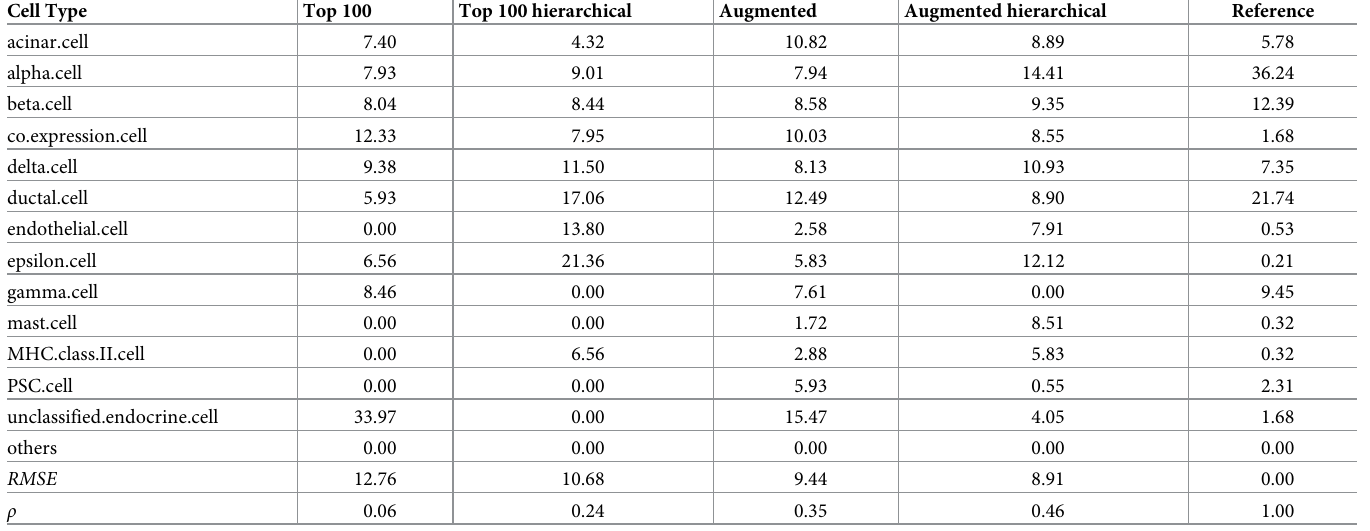
Table 5. Deconvolution of pancreas test